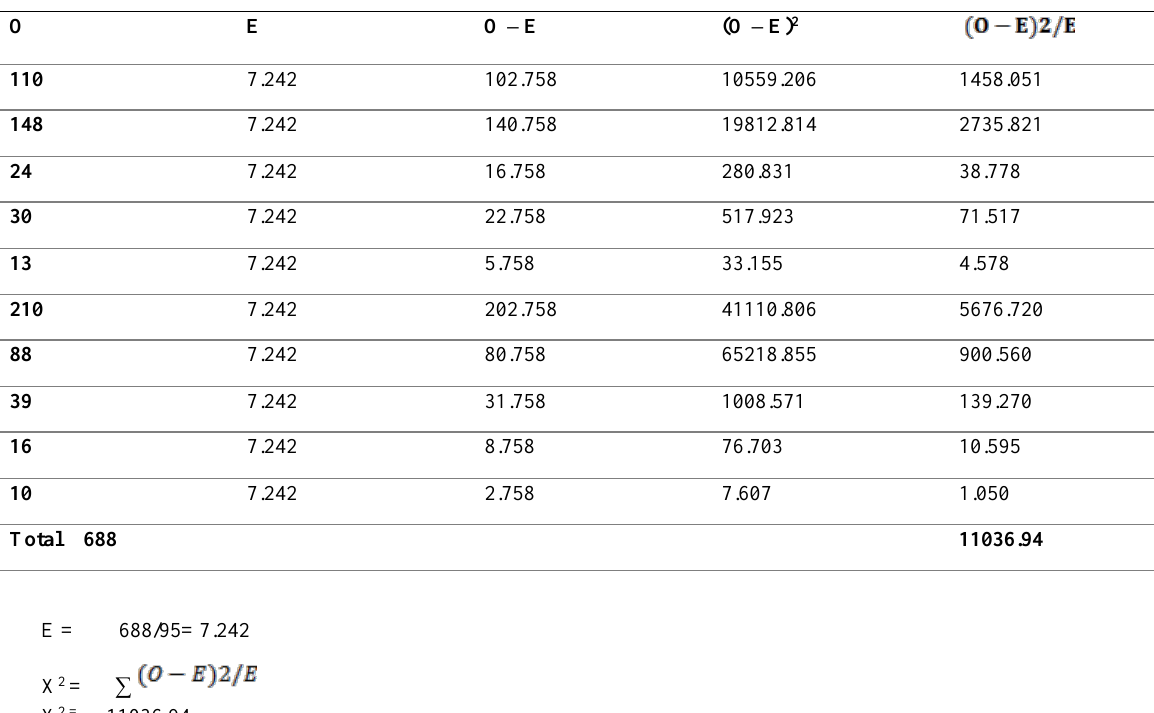
Table 4: Test of Research